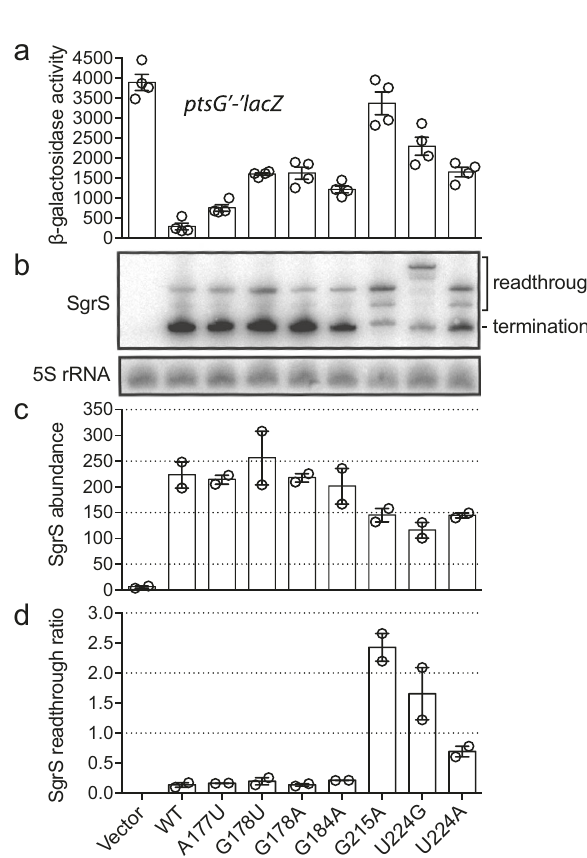
Fig. 3 Regulation of ptsG ′ - ′ lacZ translational fusion by SgrS point mutants. a Regulation of chromosomal ptsG ′ - ′ lacZ translational fusion by wild- type SgrS and A177U, G178U, G178A, G184A, G215A, U224A, and U224G mutant variants (plasmid-encoded) was assessed using β -galactosidase activity assay. Data were obtained from n = 4 independent experiments and presented as mean±SEM. b RNA was extracted simultaneously with β -galactosidase activity assay and northern blot was performed on two biological replicates using probes speci fi c for SgrS sRNA and 5S rRNA (control). Full-length (227nt), properly terminated SgrS transcripts are labeled as “ termination ” products, and longer transcripts that arose due to transcriptional readthrough are labeled as “ readthrough ” products. c Band intensities of total SgrS transcripts (termination + readthrough) were measured, and 5S-normalized values were plotted as “ SgrS abundance ” (steady-state transcript abundance of SgrS mutants). Data were obtained from n = 2 independent experiments and presented as mean±SEM. d Band intensities of SgrS termination and readthrough products were measured and 5S-normalized ratios (readthrough/ termination) were calculated and plotted for each SgrS mutant as “ SgrS readthrough ratio ” . Data were obtained from n = 2 independent experiments and presented as mean±SEM. Source data are provided as a Source data fi